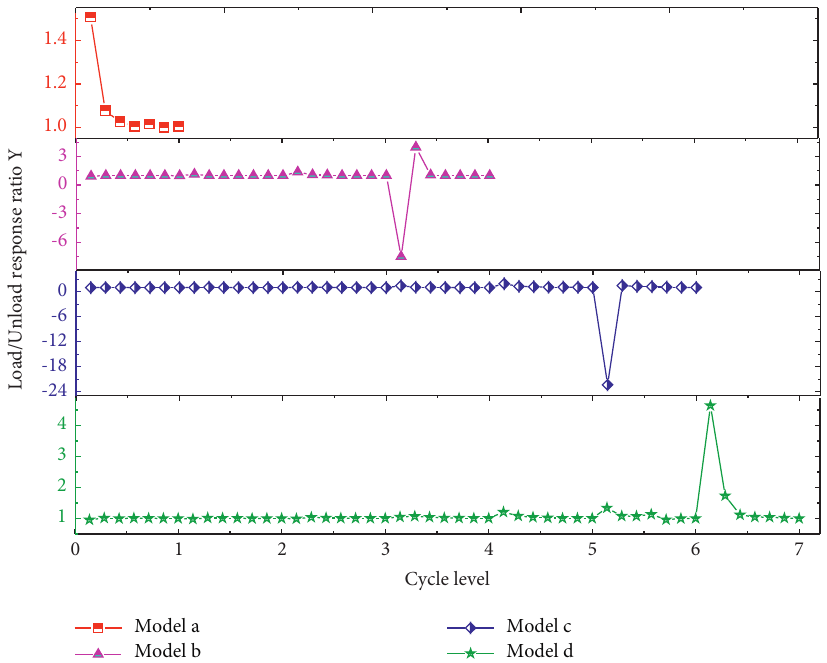
Figure 20: Load/unload response ratio of coal sample with different particle